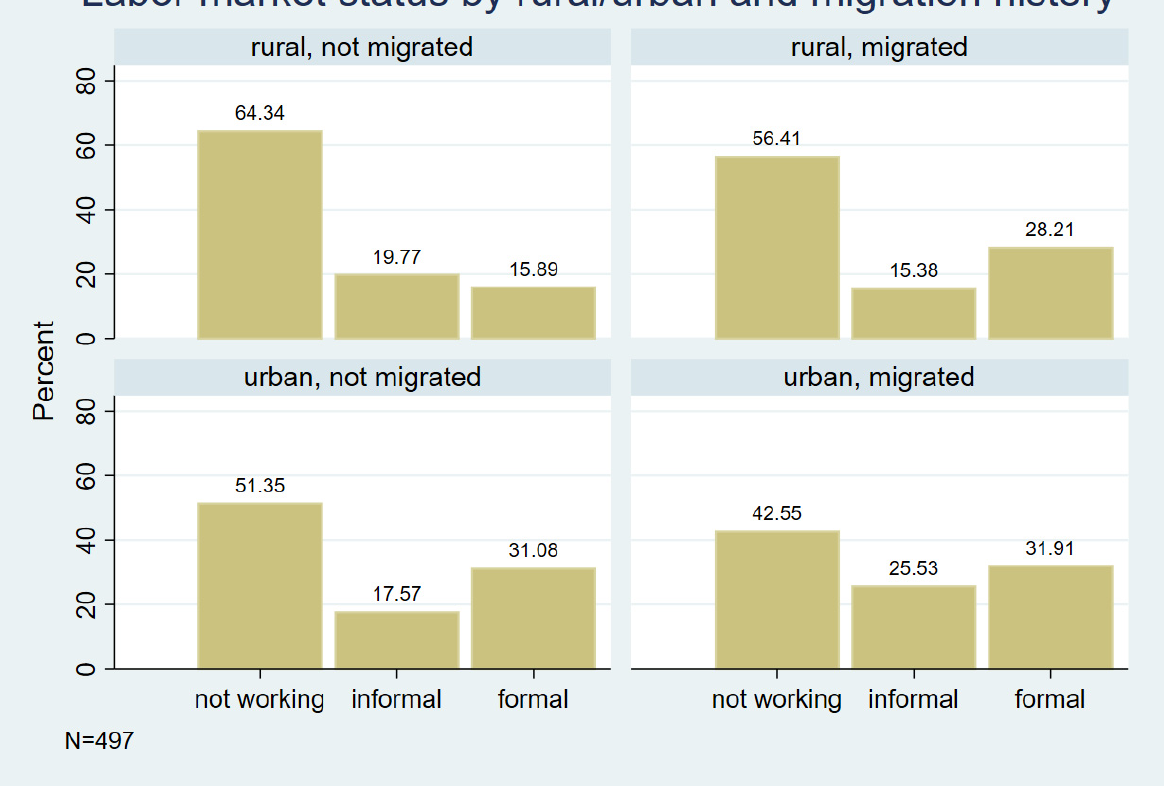
Figure 3. Labor market status by rural or urban and migration history (past five years).